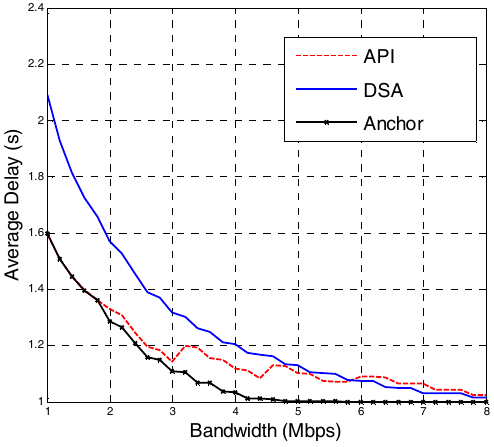
Figure 6. Average playback delay of different strategies.